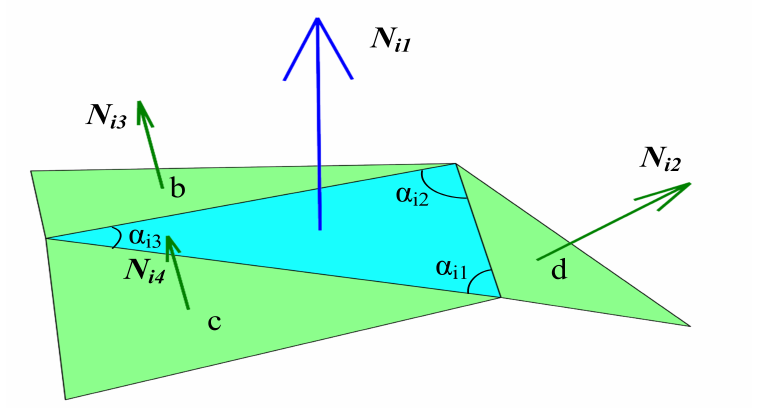
Figure 3. The three internal angles of a face and the normals of the face and its adjacent